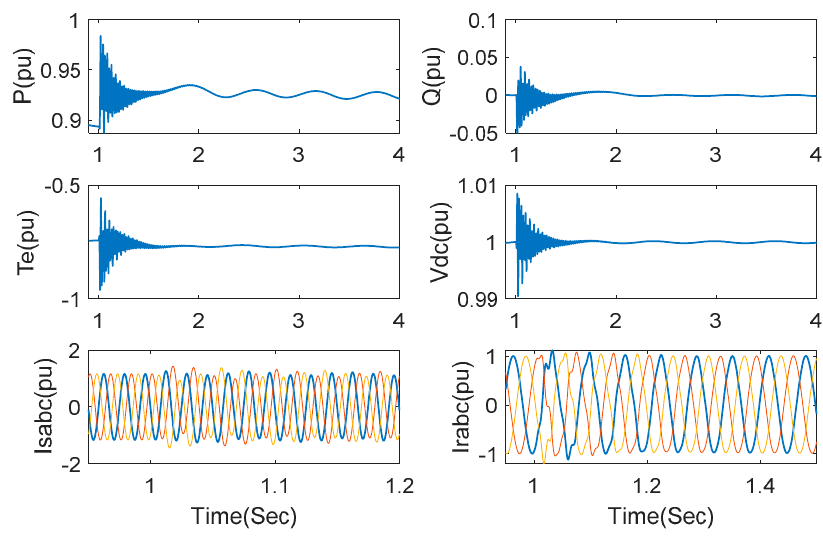
Figure 9. Responses under the proposed method with series compensation 75% and wind speed 15 m/s.